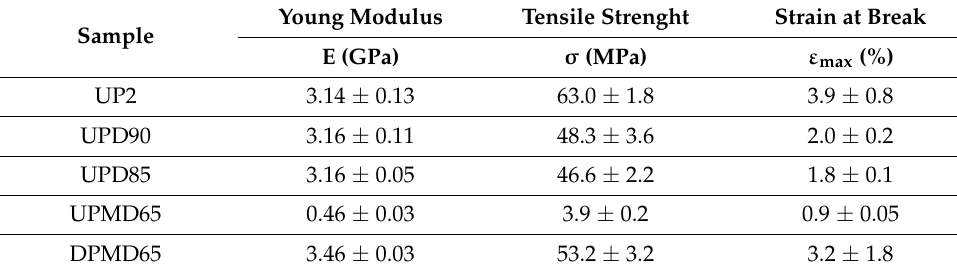
Table 12. Tensile properties of the UPRs.